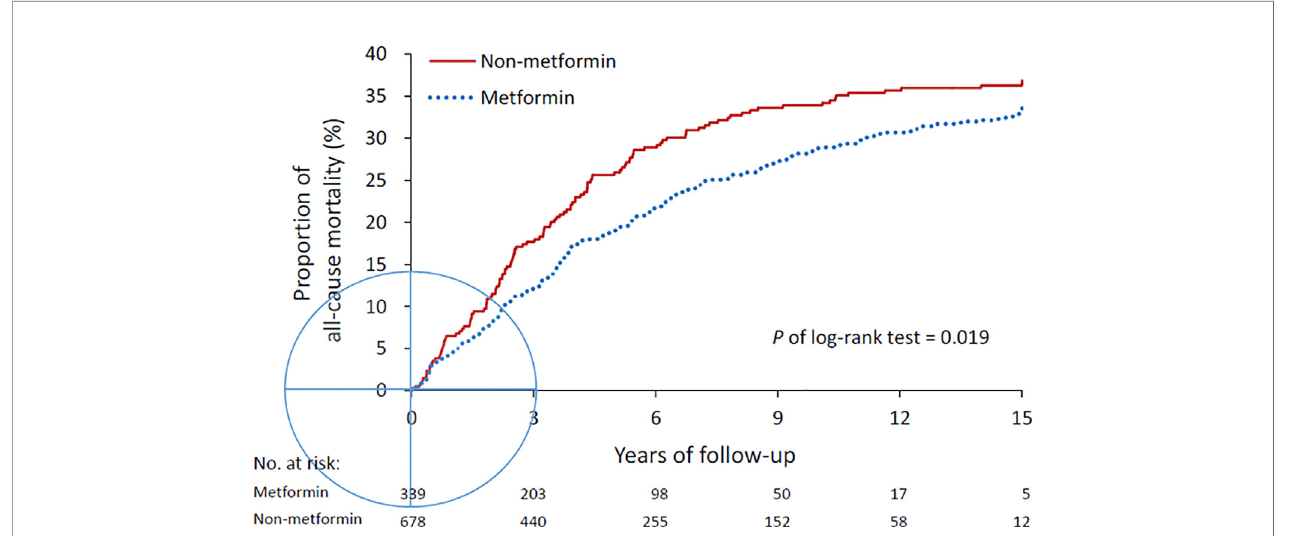
FIGURE 2 | All-cause mortality in the metformin and non-metformin groups. Mortality was compared using log-rank